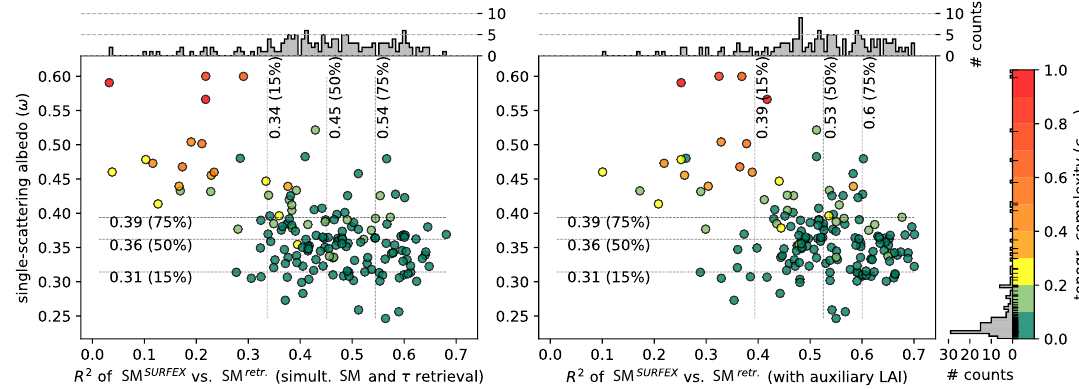
Figure 13. Dependency of R 2 for retrieved vs. SURFEX SM -timeseries (with and without the use of auxiliary LAI datasets) to ω . To highlight the impact of topography on the obtained ω - and R 2 -values, results are color-coded with respect to c topo . The labelled lines indicate the 15, 50 and 75